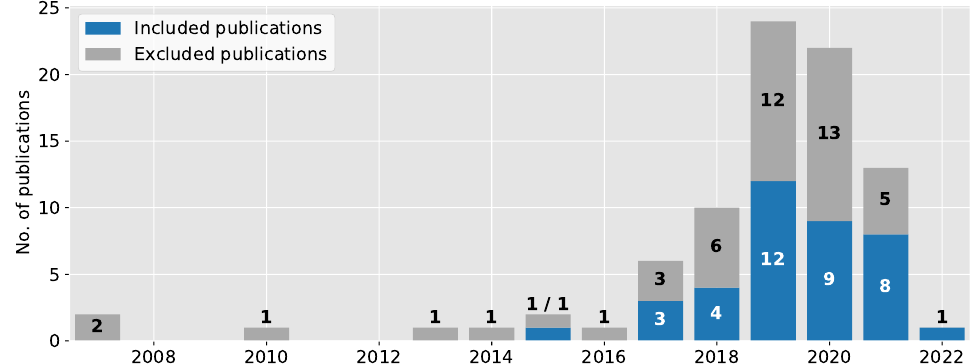
Figure 4. Overview of included (in blue) and excluded (in gray) publications per year. In total, we included 38 of 84 identified publications regarding the analysis of digital twin applications in the food industry.